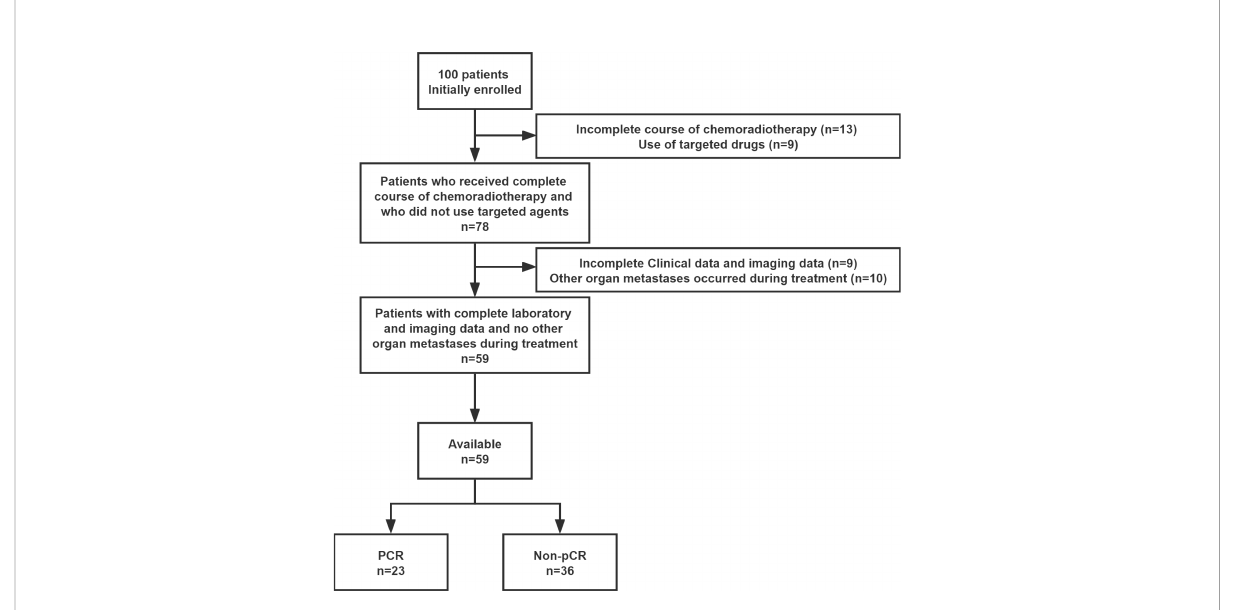
FIGURE 1 Filtering process of patient data from the initial inclusion of